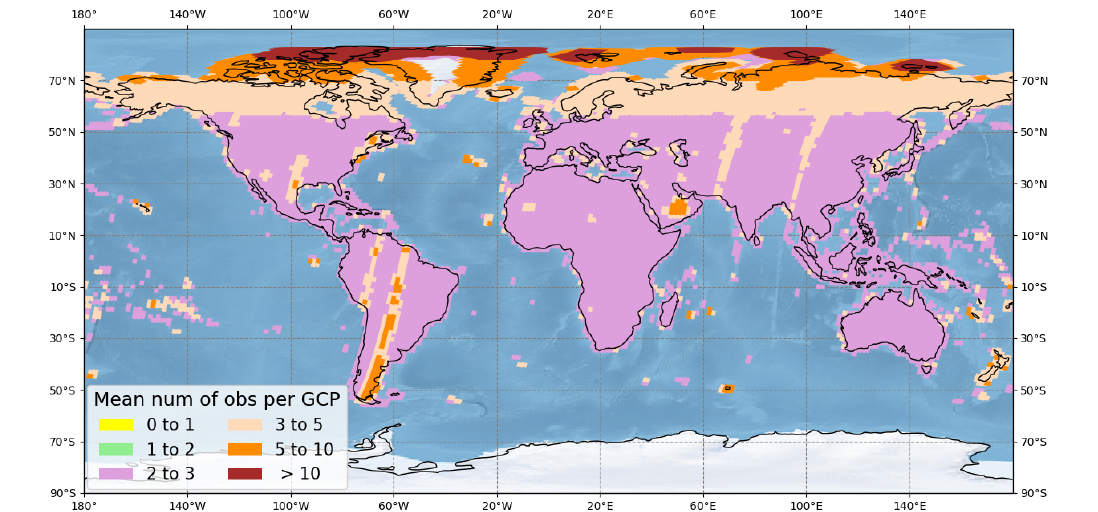
Figure 5. Average number of observations per GCP for each World Reference System (WRS)-2 path/row used in the bundle adjustment procedure. The large overlap in the northern latitudes generates a higher number of observations per